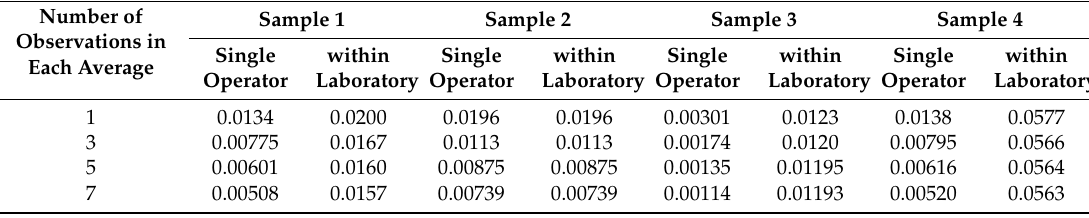
Table 11. Critical differences of compression resilience index for compression